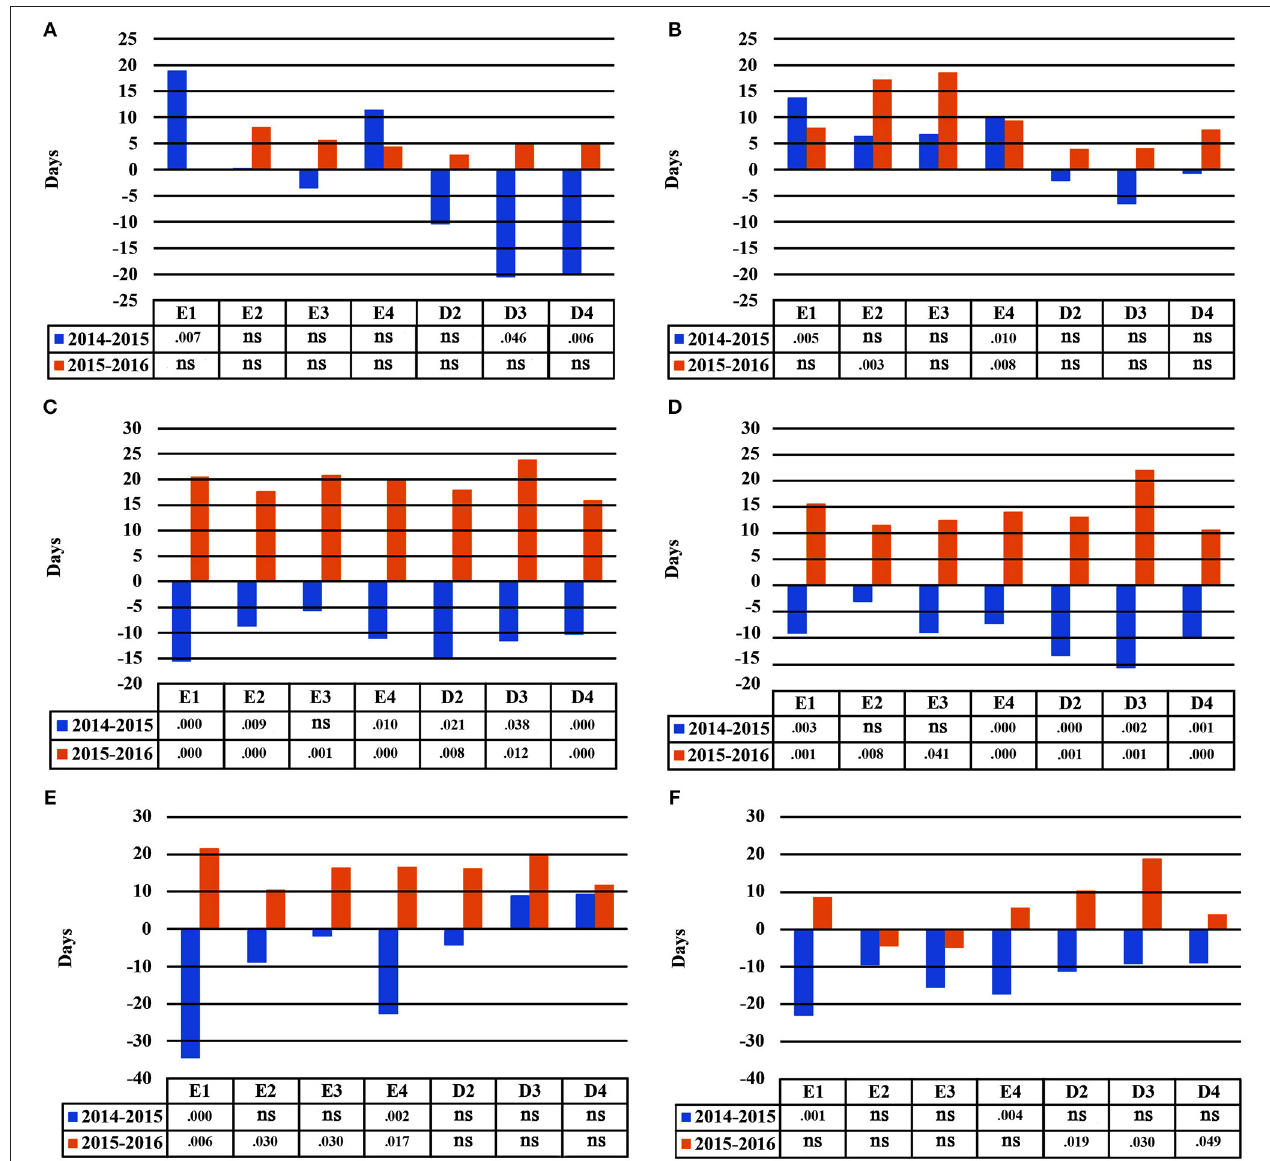
FIGURE 7 | Plastic response of populations between consecutive years of the experiment under irrigation schemes A1 and A2 respectively for bud burst (A,B) , leaf senescence (C,D) , growing period (E,F)